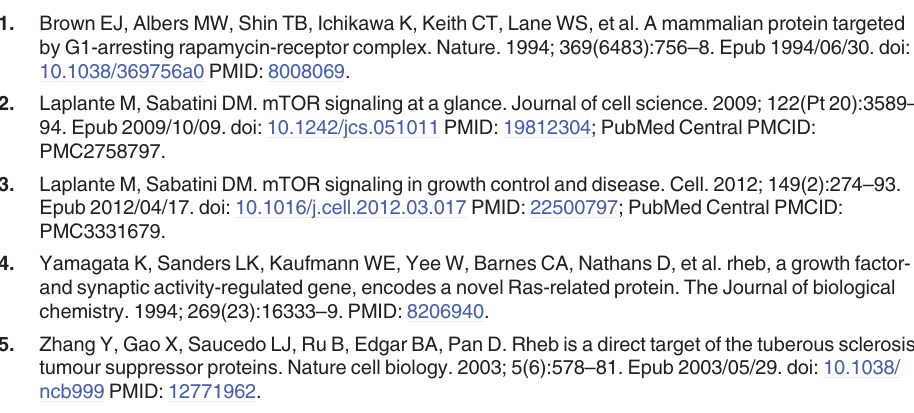
show the percentage of Foxp3+ cells obtained from the sorted mTOR hi and mTOR lo ‘ suppres- sor ’ populations used in the suppression assay depicted in Fig. 5E. C) The histograms depict the CTLA-4 expression of the Foxp3+ or Foxp3- populations gated in b. The CTLA-4 MFI is shown in the upper corner of the FACs plot. The data are representative of 3 independent ex- periments. (TIFF) S6 Fig. Foxp3+ T cells are de novo generated upon TCR stimulation in conditions of low mTORC1 activation. a-d) Splenocytes from WT Foxp3GFP+ mice were stimulated with 0.1ug/ml anti-CD3 for 20 hrs, and then sorted into CD4+CD69+GFP negative FSC/SSC “ big ” mTOR hi and “ small ” mTOR lo populations. a) A schematic of the sorting strategy used. b-d) Sorted cells were cultured in media supplemented with IL-2 for 3 days. b) Foxp3+ expression was determined by flow cytometry. c) FACs plots show the dilution of eFluor670 labeled naive CD4+ ‘ responder ’ cells after 72hrs of stimulation in co-culture (2:1 responder: suppressor) with mTOR hi or mTOR lo cells. d) The histograms depict the CTLA-4 expression of the Foxp3+ or Foxp3 negative populations gated in b. The CTLA-4 MFI is shown in the upper corner of the FACs plot. The data are representative of at least 3 independent experiments. (TIFF) S7 Fig. TGF-ß does not inhibit mTOR signaling in activated CD4+ T cells. Splenocytes from a 5c.c7 Rag – / — mouse were stimulated with anti-CD3 and anti-CD28 for 4hrs in the pres- ence or absence of 5ng/ml TGF-ß or 500nM rapamycin. Cells were then lysed, and mTOR ac- tivity was determined by western